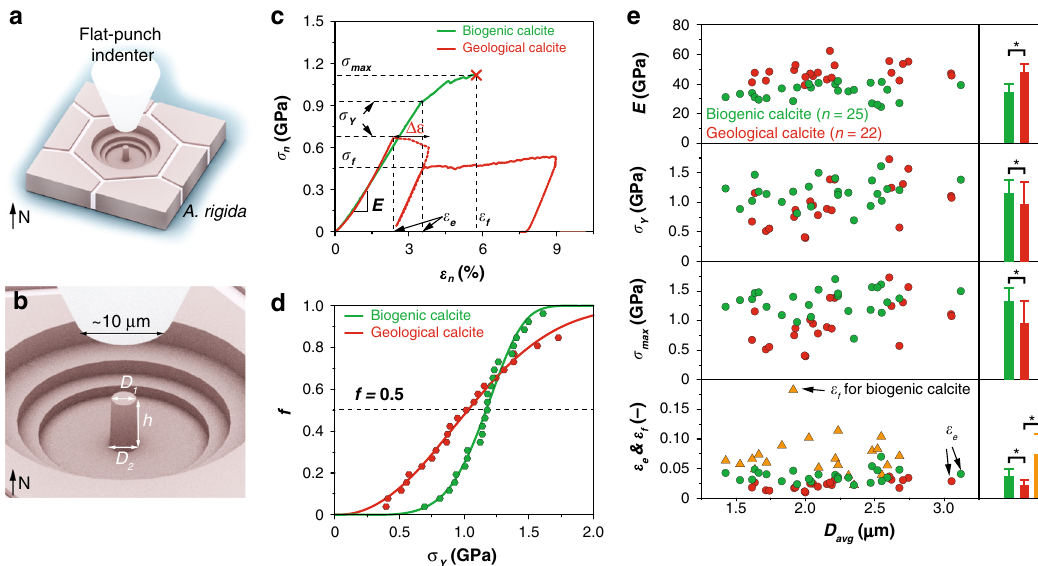
Fig. 3 Quantitative mechanical properties of biogenic and geological calcite via uniaxial micro-pillar compression tests. a , b Schematic illustrations of the uniaxial compression of micro-pillars with a fl at-end diamond tip (bottom diameter, 10 µ m). The parameters of the micro-pillars include D 1 (top diameter), D 2 (bottom diameter), and h (height of the micro-pillars). c Representative normalized engineering stress-strain ( σ n - ε n ) curves for uniaxial compression of the biogenic and geological calcite micro-pillars. The calculated mechanical parameters include E (Young ’ s modulus), σ Y (yield strength), σ ε ε σ fl ow strength for geological calcite). d Weibull analysis of σ max (maximum strength), e (elastic limit), f (failure strain), and f ( Y , where f is the failure percentage. e Measured distribution of E , σ Y , σ max , ε e , and ε f as functions of the pillar average diameter, D avg . The histograms on the right show the average and standard deviation of each data set. Asterisks represent statistical signi fi cance at a level of 0.05 via two sample t -tests.